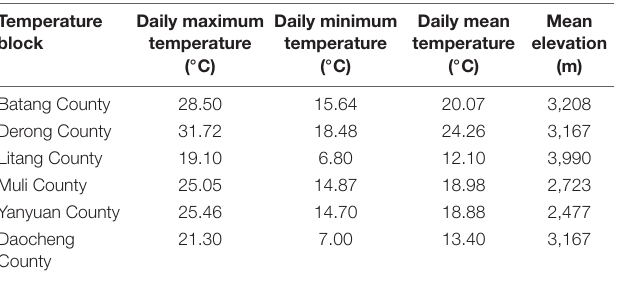
TABLE 1 | Temperature data of six temperature blocks in the Shaluli Mountains. Temperature